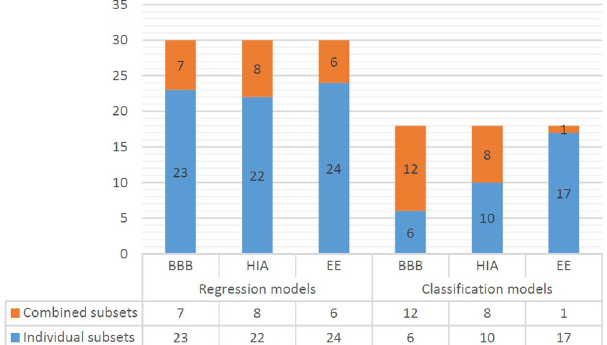
Figure 11. Number of experimental scenarios where QSAR models obtained by combined subsets improve the performance of the QSAR models inferred by individual